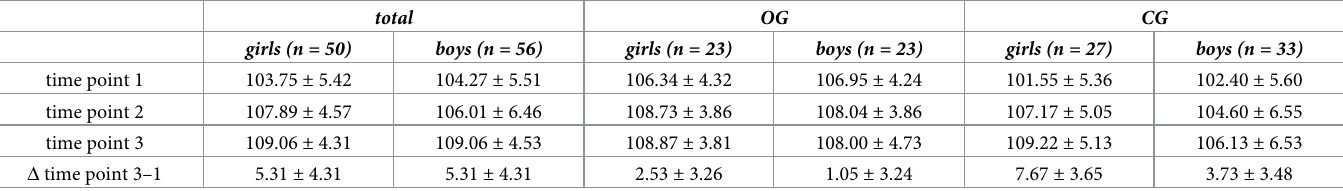
Table 3. Motor performance score separated by gender and groups.